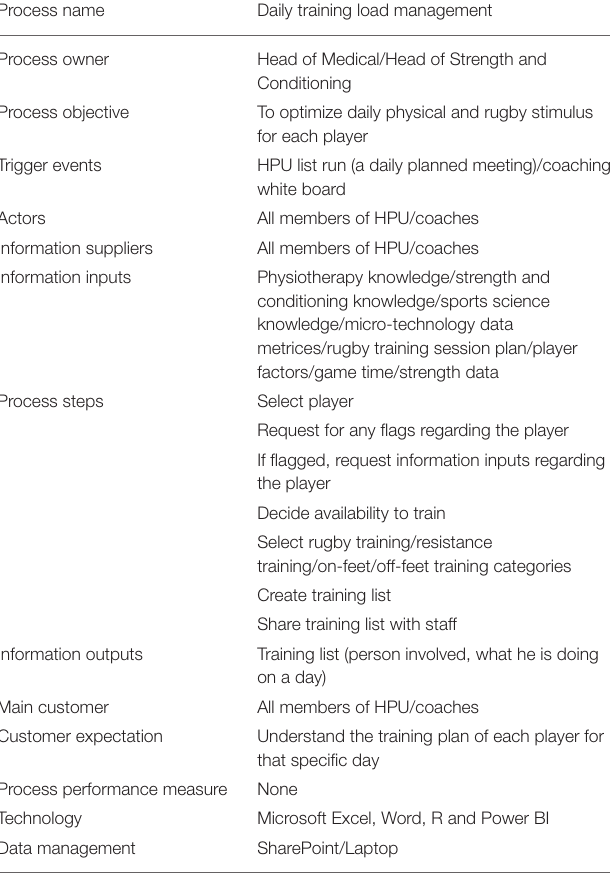
TABLE 5 | Data collected to model As-Is state of daily training load management (M2)